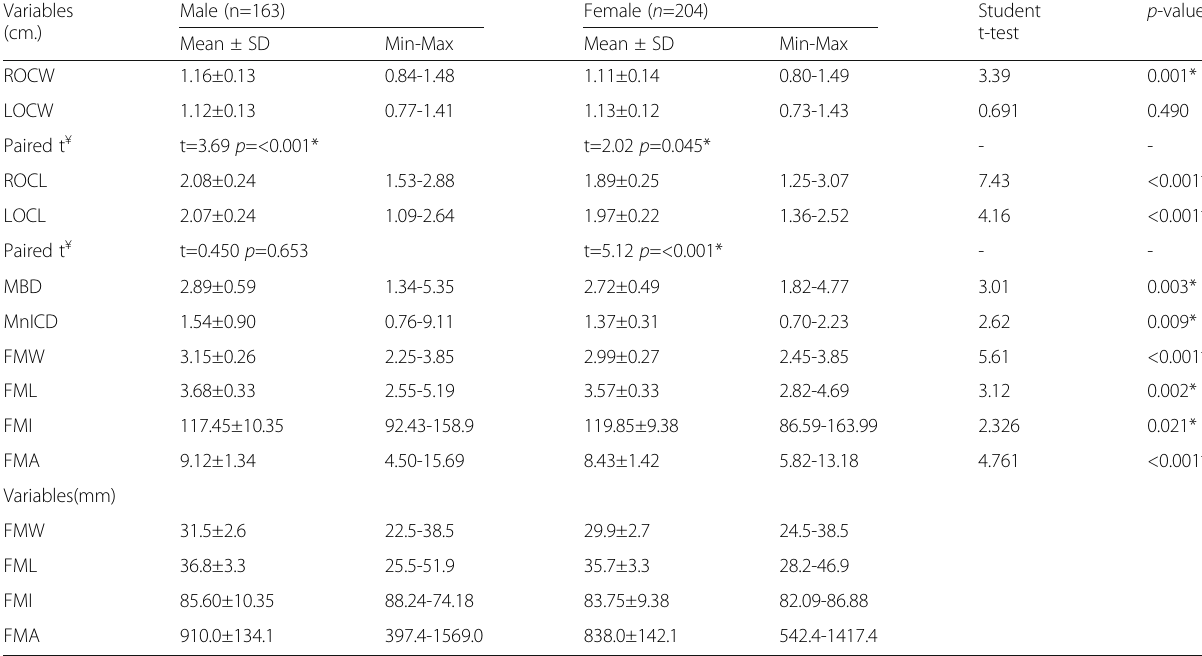
Table 1 Sex differences of foramen magnum and occipital condyles dimensions among the studied Egyptian population ( n =367) Variables